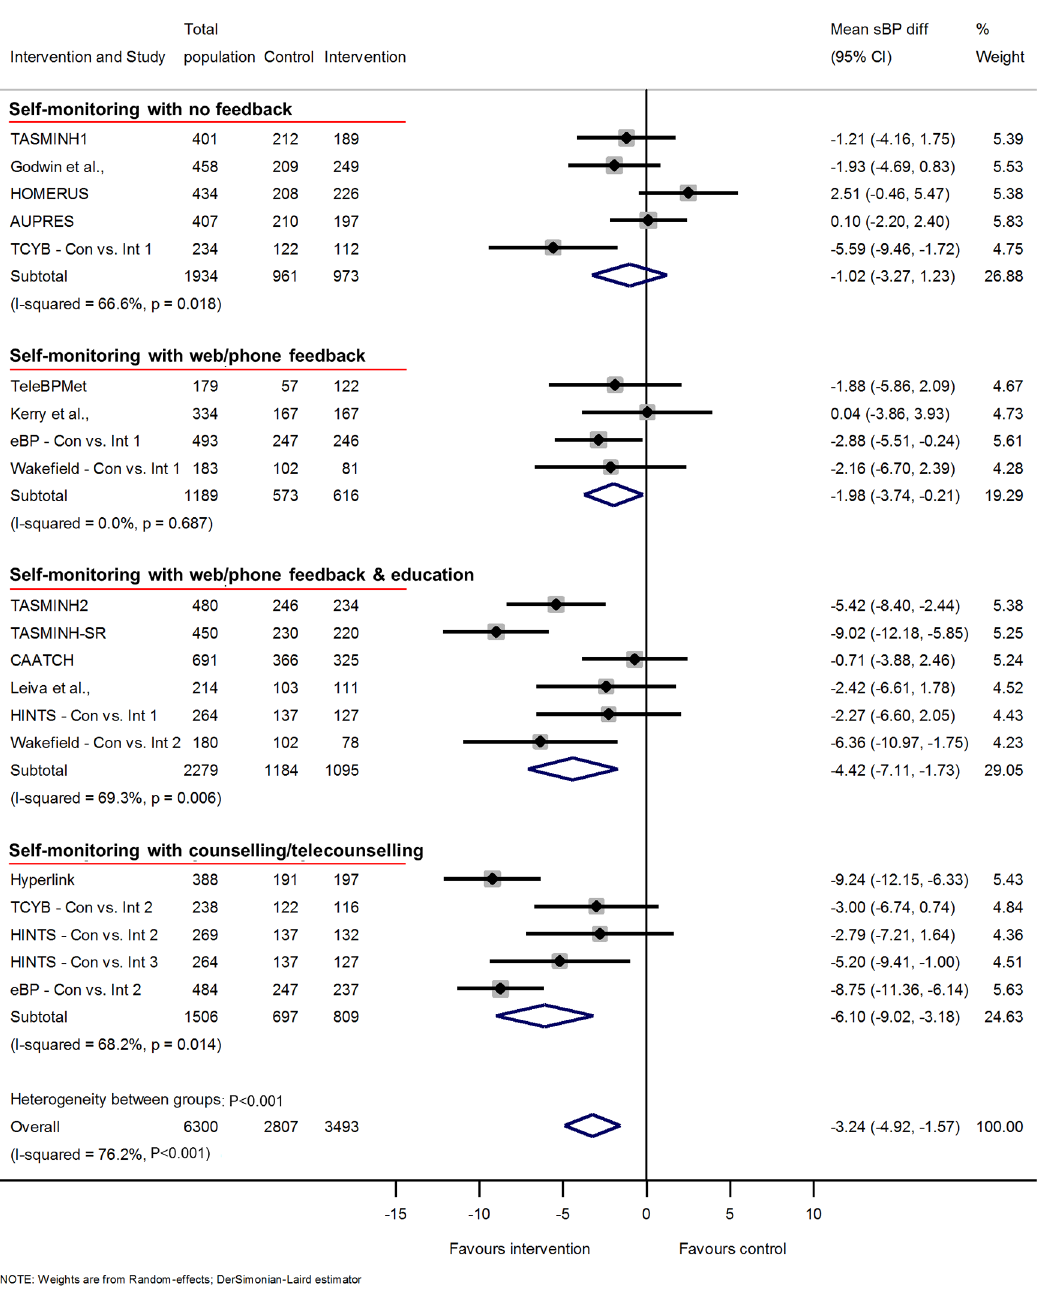
PLOS Medicine| https://doi.org/10.1371/journal.pmed.1002389 September 19,